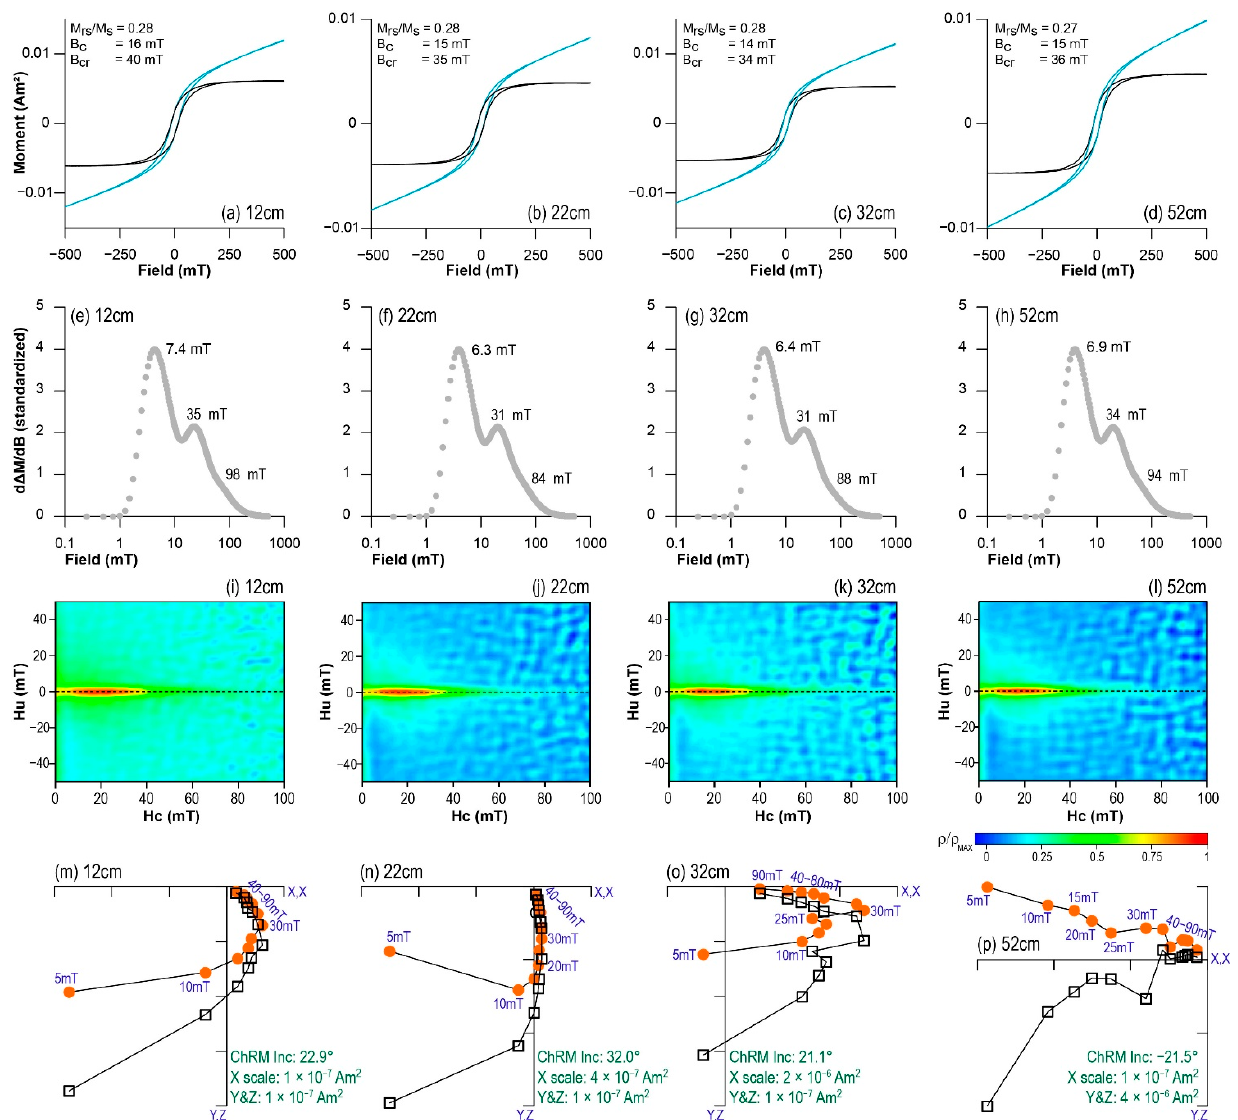
Figure 2. Magnetic properties of core MABC–11. ( a – d ) Hysteresis loops (blue line, uncorrected curve; black line, corrected curve); ( e – h ) Unmixing of the second derivate of hysteresis loop data to show coercivity components; ( i – l ) First-order reversal curve (FORC) diagrams; ( m – p ) Orthogonal diagrams of the stepwise alternating field (AF) demagnetization. Due to the 5–10 times higher relative to AF at RM 5mT , the natural remanent magnetization (NRM) points are not shown. Solid (open) circles (squares) represent the vertical (horizontal) plans.